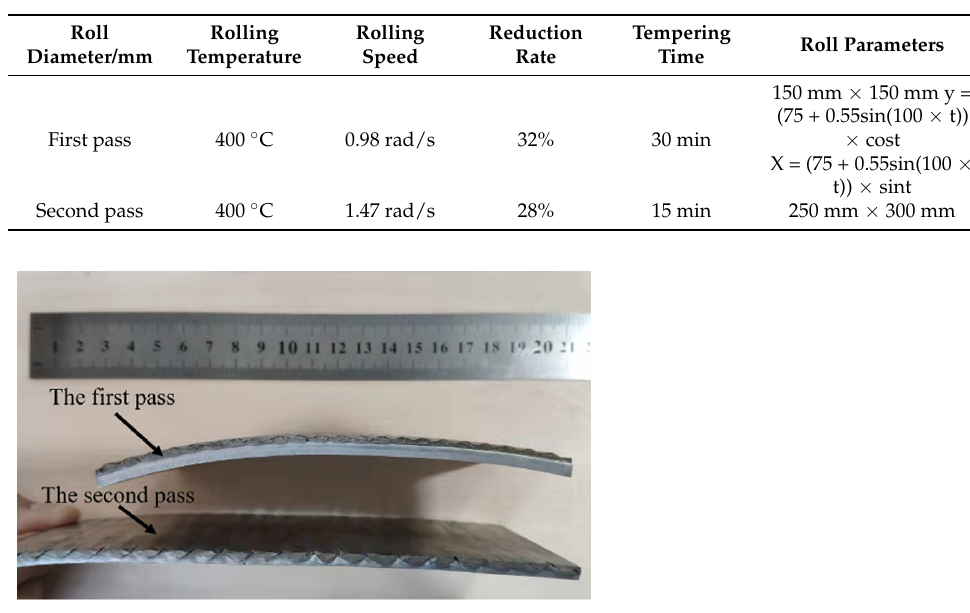
Figure 1. Schematic diagram of rolling-straightening process of Mg/Al corrugated composite plate. Table 1. Rolling parameters of Mg/Al corrugated composite plate.